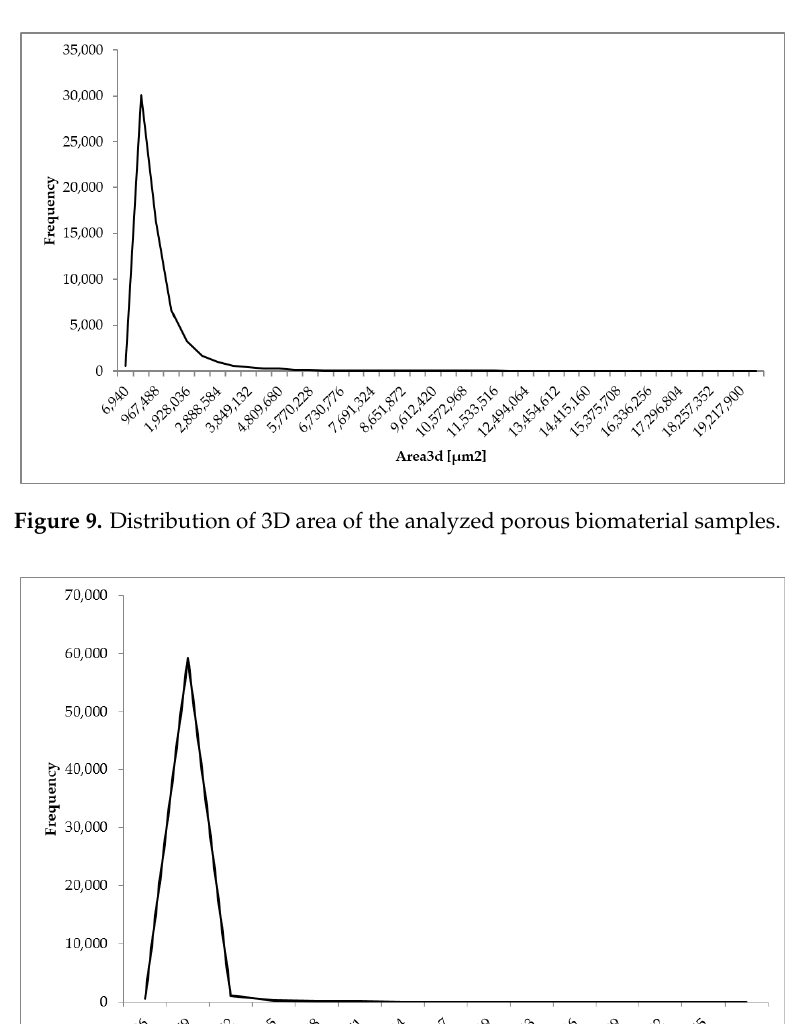
Figure 8. Distribution of equivalent diameter of the analyzed porous biomaterial samples.